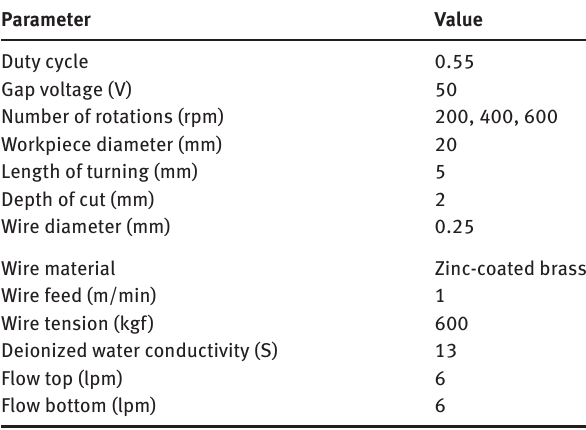
Table 3: Technical conditions of